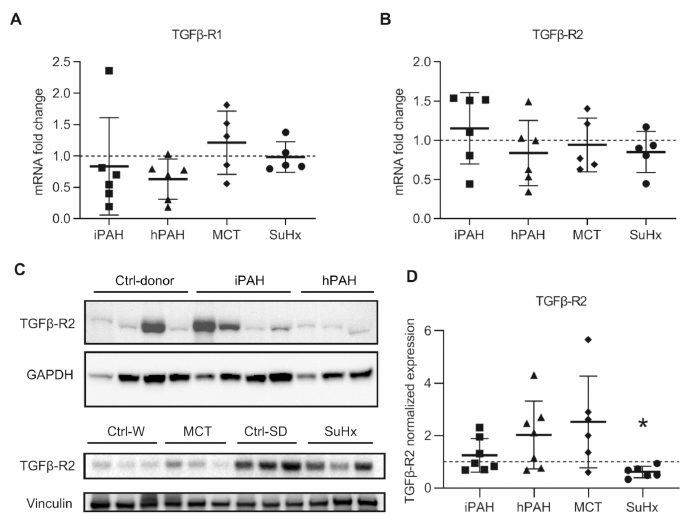
Figure 3. The expression of transforming growth factor- β receptors (TGF β R): ( A ) the mRNA expres- sion of TGF β R1 analyzed by qPCR; ( B ) the mRNA expression of TGF β R2 analyzed by qPCR. n(iPAH) = 6, n(hPAH) = 6, n(MCT) = 5, n(SuHx) = 5; ( C ) representative image of Western blot analysis in whole lung lysates; ( D ) quantification data of Western blot analysis normalized to vinculin. n(iPAH) = 7, n(hPAH) = 7, n(MCT) = 6, n(SuHx) = 6. Quantification in each group is the fold change corrected by its own control group. The control group of iPAH and hPAH: donors without PAH. The control group of MCT: healthy Wistar rats. The control group of SuHx: healthy Sprague Dawley rats. iPAH: idiopathic pulmonary arterial hypertension, hPAH: hereditary pulmonary arterial hypertension,